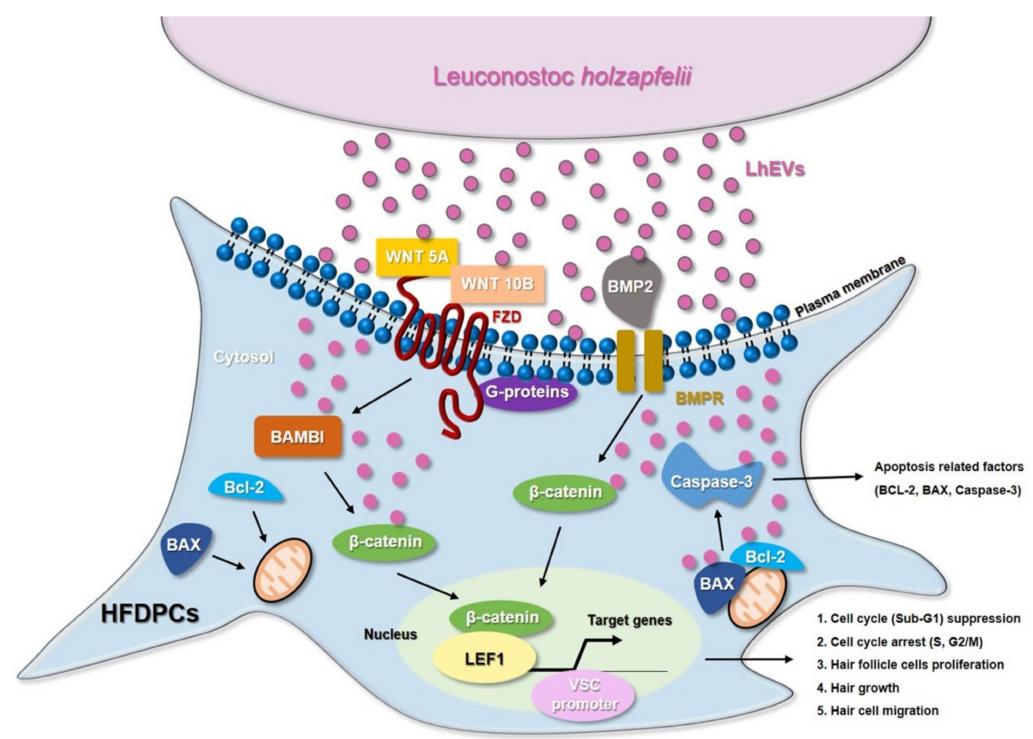
Figure 8. Schematic of the apoptosis inhibition and hair growth effects of extracellular vesicles derived from Leuconostoc holzapfelii isolated from human scalp tissue (hs- Lh EVs). Supplementary Materials: The following supporting information can be downloaded at https: clinical trials related to hair growth; Figure S2: Increase in the number of hairs in hs-LhEVs by clinical trial period; Figure S3: Changes in average hair count (N/cm2) compared to